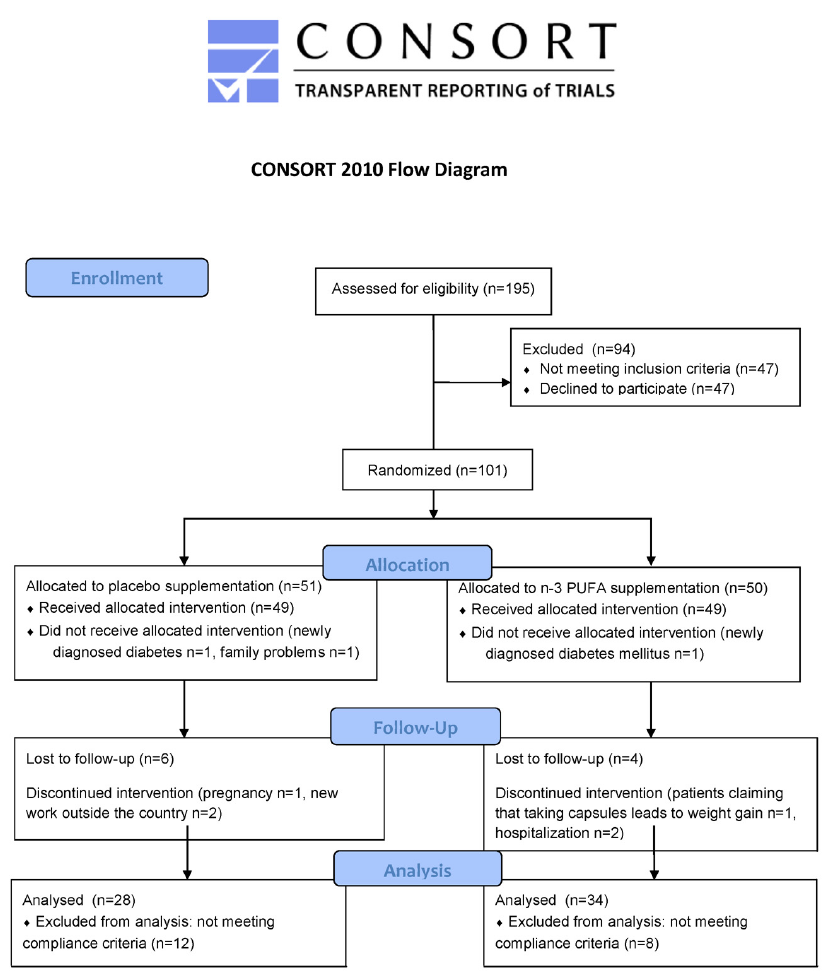
Figure 1. CONSORT flow